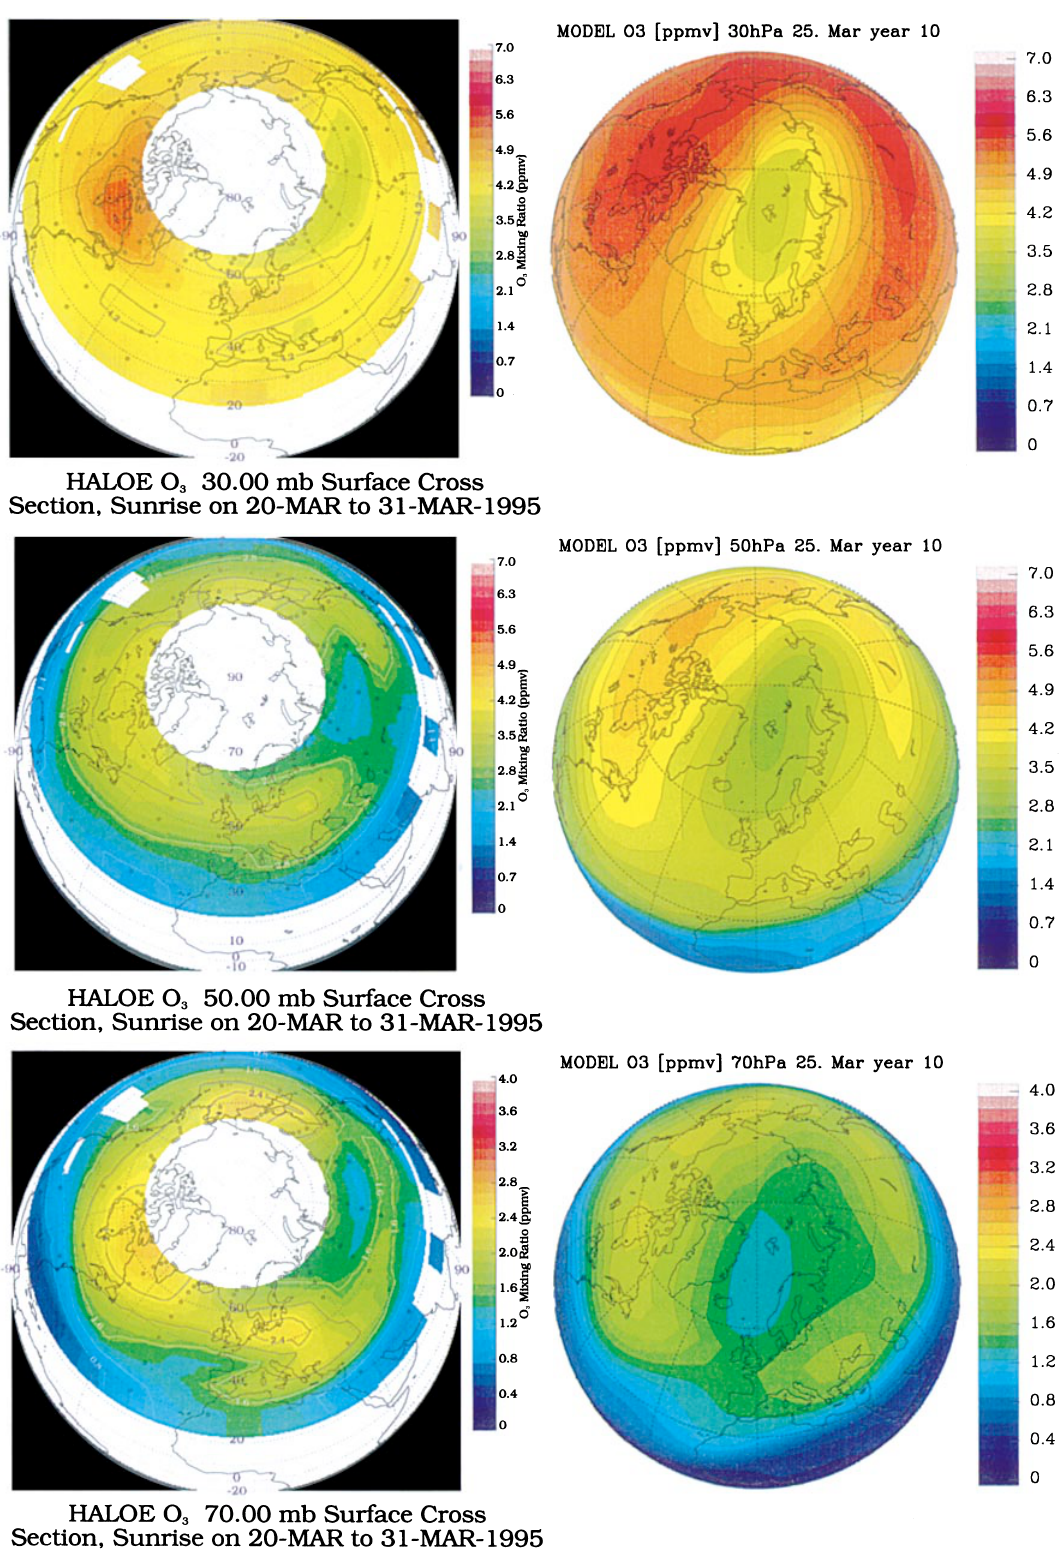
Fig. 7. Left-hand side : northern-hemisphere HALOE ozone measure- ments (in ppmv) at 30, 50 and 70 hPa, representing the time-period between 20 and 31 March 1995. Data points (o) progress from high to